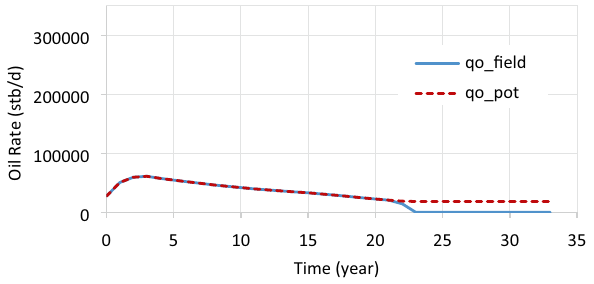
Fig. 18 Optimum oil production profile and oil production potential for strategy FPSO with GL